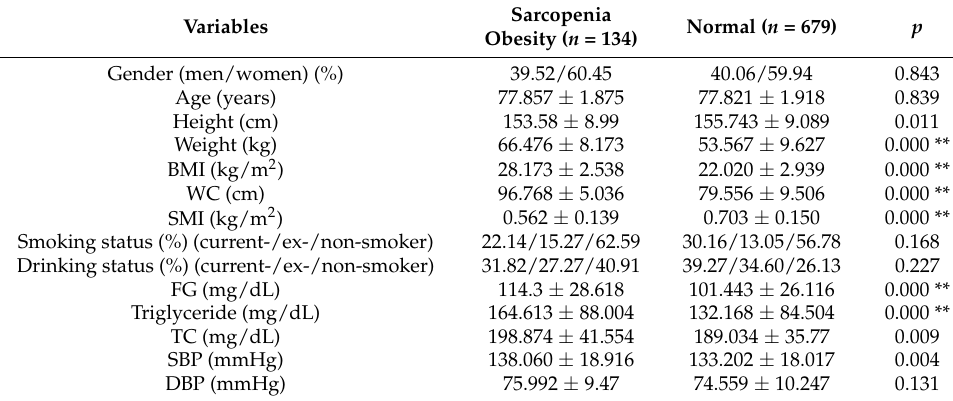
Table 1. General characteristics of the participants ( n =